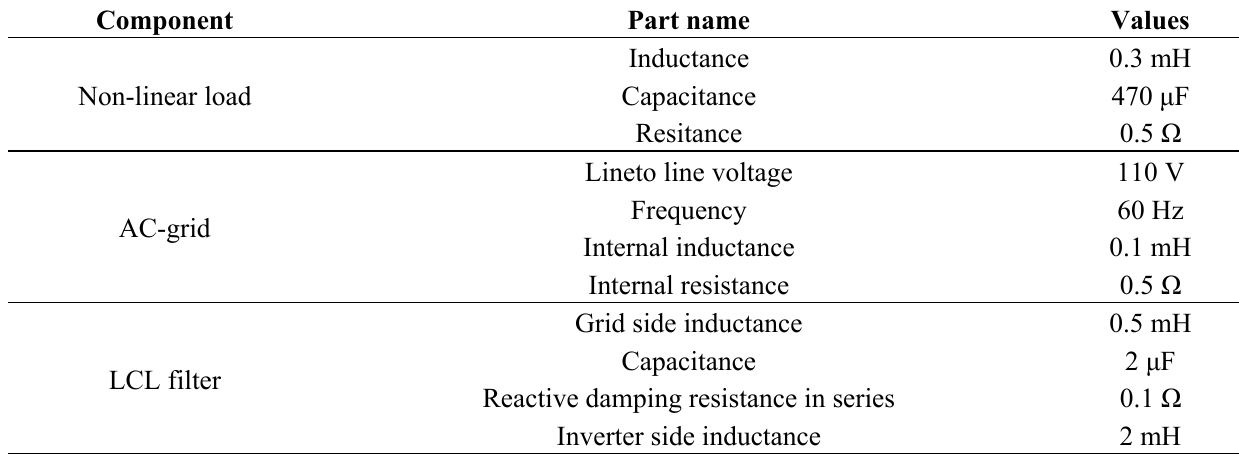
Table 1. Parameter specifications adopted for simulation. AC: alternating current; and LCL: